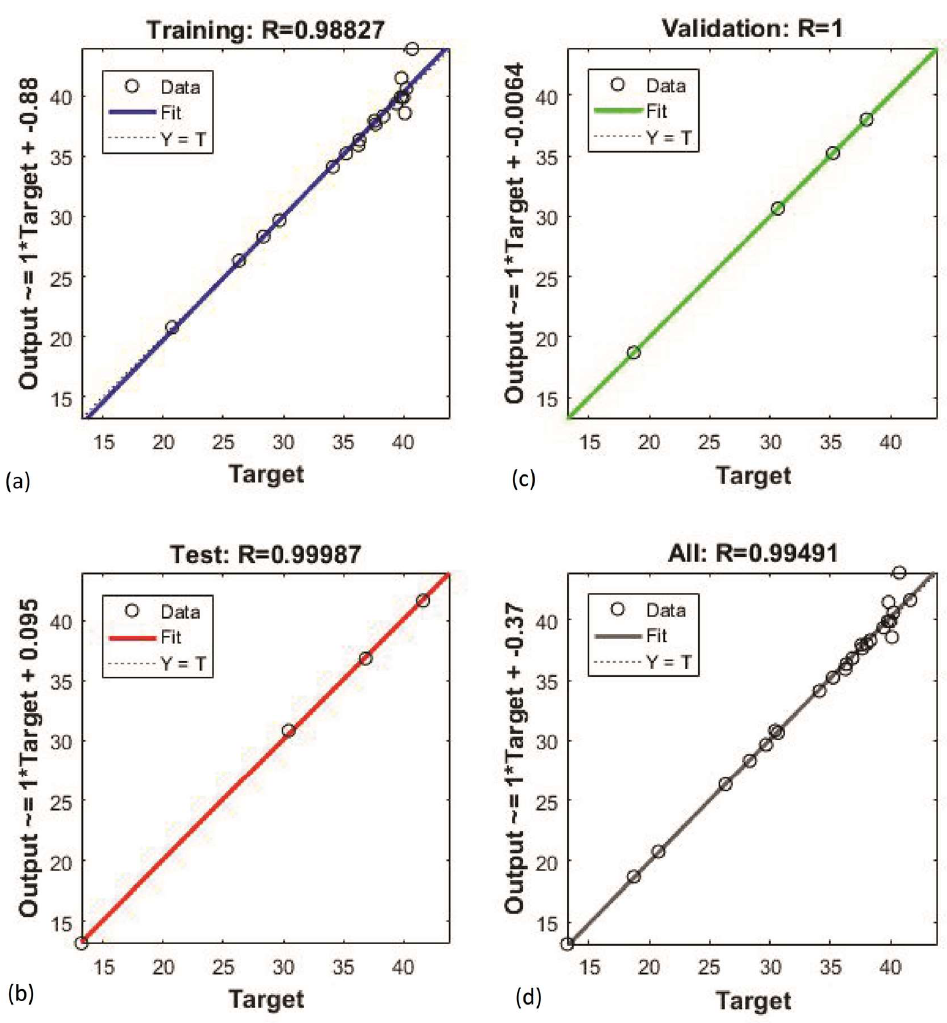
Figure 3. Scatter plot between experimental and predicted yield by artificial neural network (ANN) for ( a ) training, ( b ) testing, ( c ) validation, and ( d ) overall data